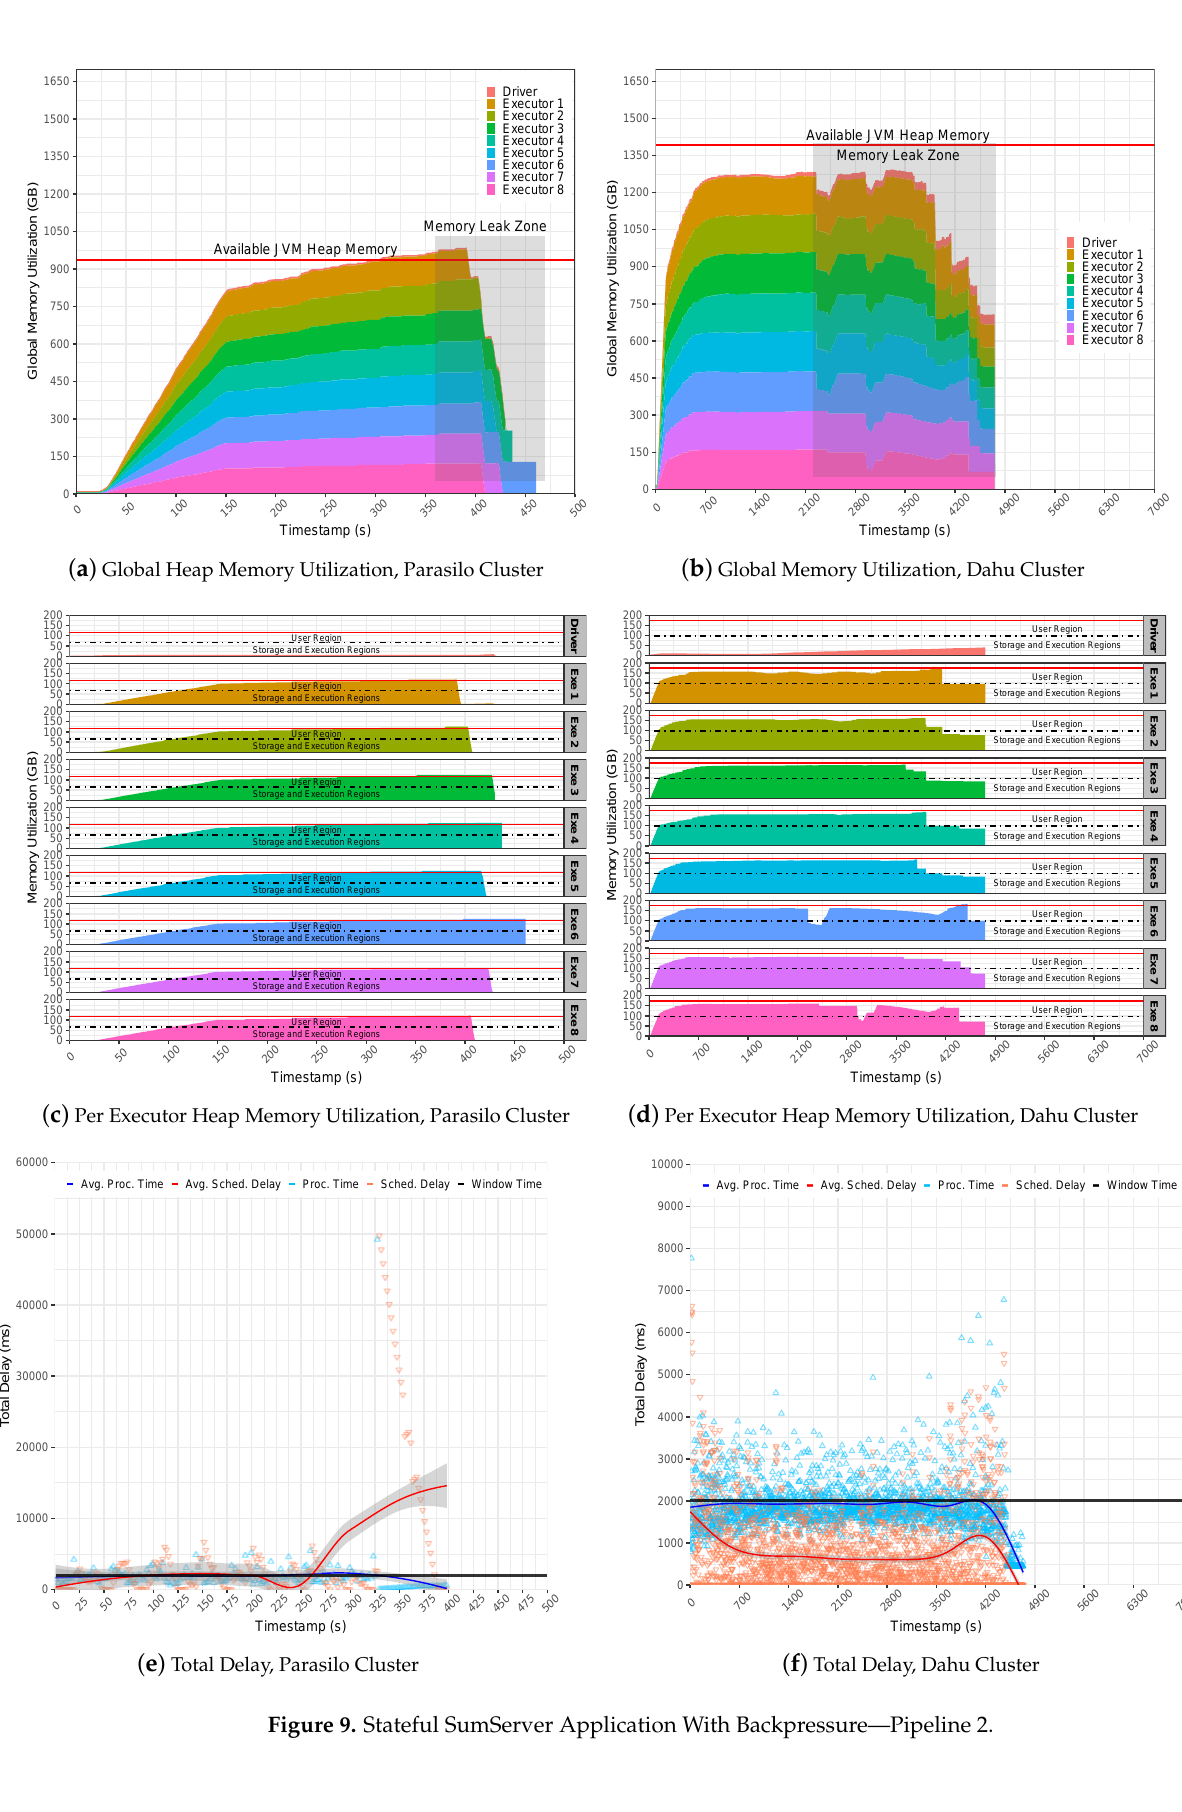
Figure 9. Stateful SumServer Application With Backpressure—Pipeline